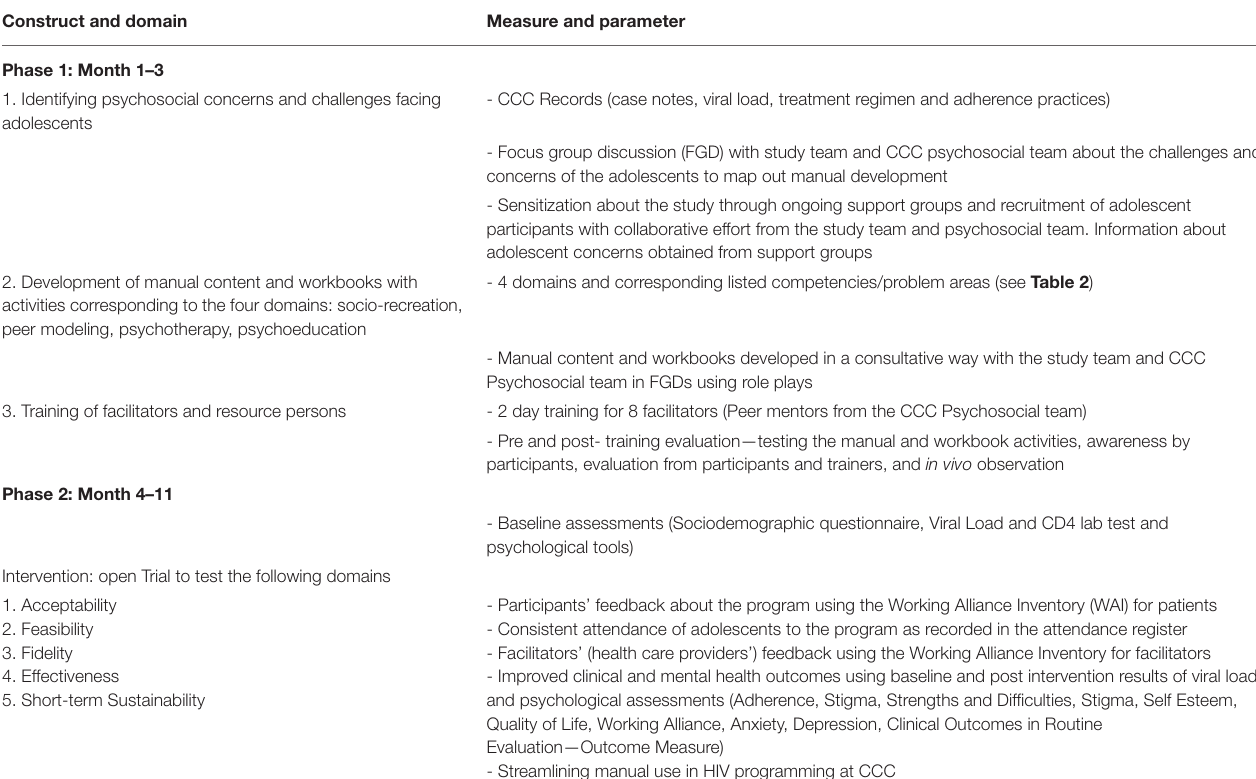
TABLE 1 | Domain and parameters in data